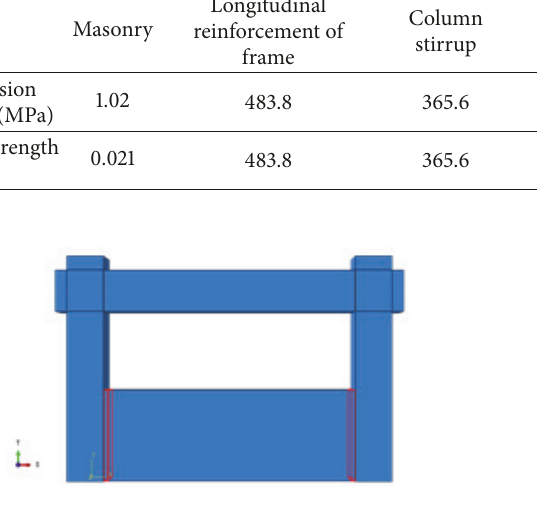
Figure 11: Finite element model of specimen